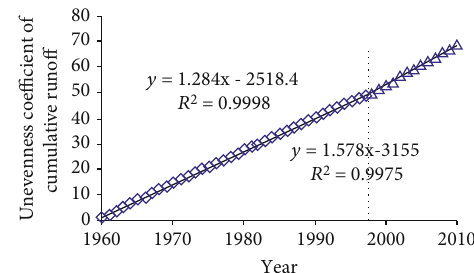
Figure 7: Unevenness coe ffi cient of cumulative run.